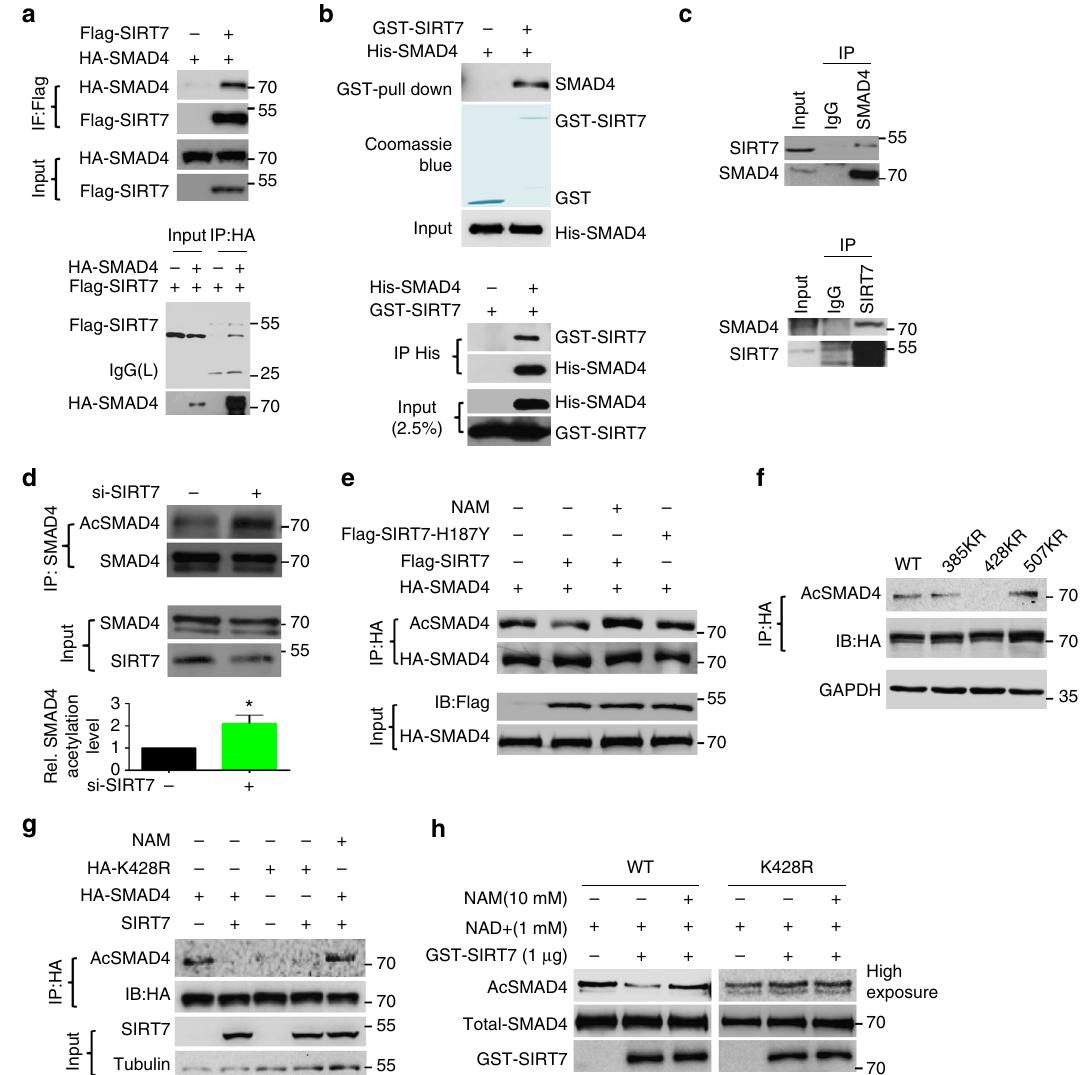
Fig. 5 SIRT7 deacetylates SMAD4. a Immunoblots showing HA-SMAD4 in the anti FLAG-SIRT7 immunoprecipitates ( upper ) and FLAG-SIRT7 in the anti HA-SMAD4 immunoprecipitates ( lower ). b GST pulldown with puri fi ed GST-SIRT7 ( upper ) and Ni-NTA pulldown with 6× His-SMAD4 ( lower ) followed by immunoblotting with anti SMAD4 and SIRT7 antibodies. c Co-immunoprecipitation of endogenous SMAD4 with anti SIRT7 antibodies ( upper ) and endogenous SIRT7 with anti SMAD4 antibodies ( lower ) in BT549 cells. d Acetylation level of SMAD4 in BT549 cells treated with Scramble or si-SIRT7, probed with pan anti acetyl lysine antibodies. Lower is quantitative data showing increased level of SMAD4 acetylation in cells with SIRT7 KD. e Immunoblots showing the acetylation levels of SMAD4 in the presence of wild-type, enzyme-dead SIRT7 (H187Y), and/or NAM (10 mM). f Immunoblots showing acetylation levels of SMAD4 WT and KR mutants (K385R, K428R, and K507R). These proteins were immunoprecipitated with anti HA af fi nity resin and probed with pan anti acetyl K antibodies. g Immunoblots showing the acetylation levels of SMAD4 WT and K428R mutant in the presence of SIRT7 or NAM. h SIRT7-mediated in vitro deacetylation of SMAD4. Bead-bound SMAD4 or K428R mutant was included. * P < 0.05, P -value is calculated by Student ’ s t -test. Data are shown as mean ±